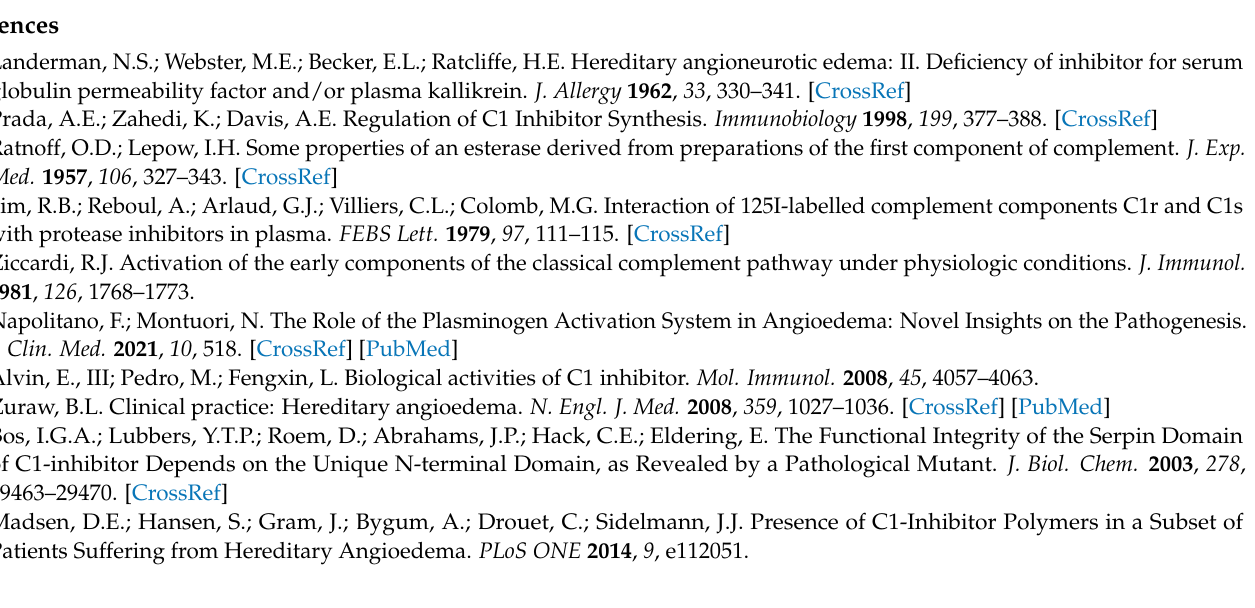
Figure S3: Complement (anti-human C1) specific activity of drugs, estimated by the level of